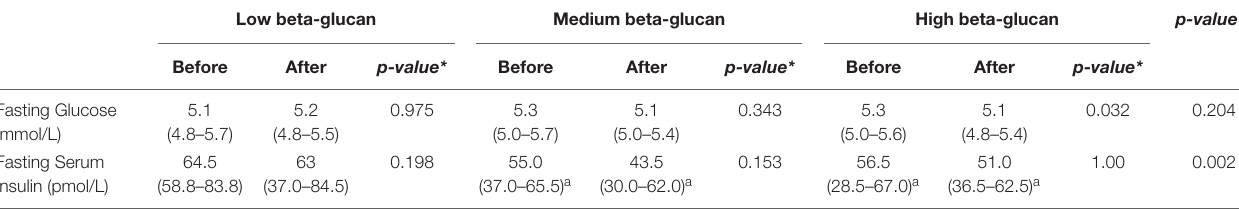
FIGURE 3 | Postprandial blood glucose response after intake of granola with cereal beta-glucan. The postprandial glucose response from 0–180 min (A) and the incremental area under the curve (B) after an OGTT at baseline and after consuming low, medium and high amount of beta-glucan for three days. Data is given as median (25 th –75 th ). Significant differences are calculated with Friedman’s Anova followed by Wilcoxon signed rank test. Significant differences are indicated with * (A) or with a p-value (B) . TABLE 4 | Fasting blood glucose and insulin values before and after intake of granola with cereal beta-glucan in different amounts. Low beta-glucan Medium beta-glucan High beta-glucan p-value